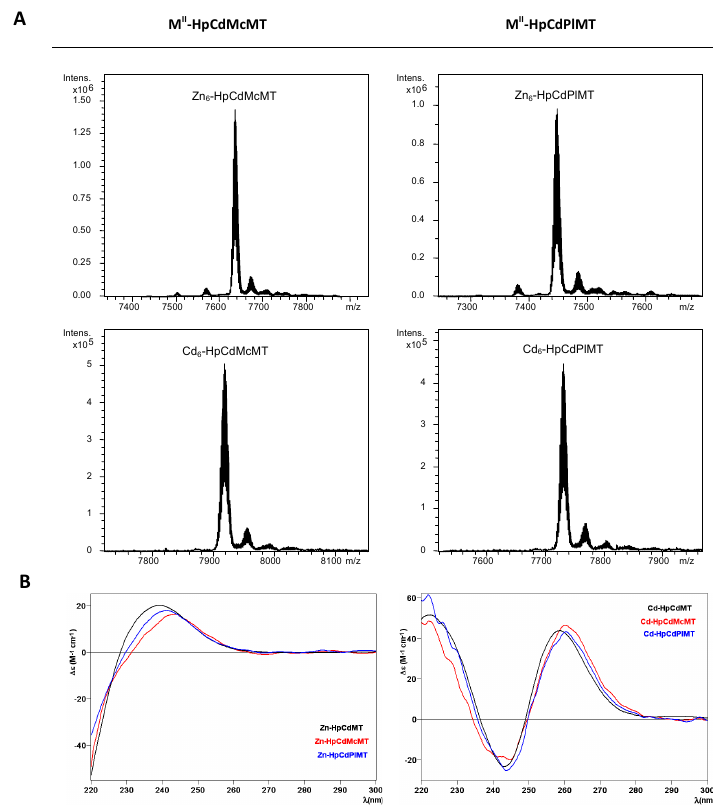
Figure 3. Analysis of the Zn- and Cd-HpCdMcMT and -HpCdPlMT complexes. ( A ) Deconvoluted ESI-MS spectra of the recombinant preparations of HpCdMcMT and HpCdPlMT purified from Zn- and Cd-supplemented cultures, analyzed at neutral pH (7.0); ( B ) CD spectra of the corresponding recombinant preparations. For comparative purposes, the CD spectra of the recombinant preparations yielded by the wild-type HpCdMT protein [11] have been included.